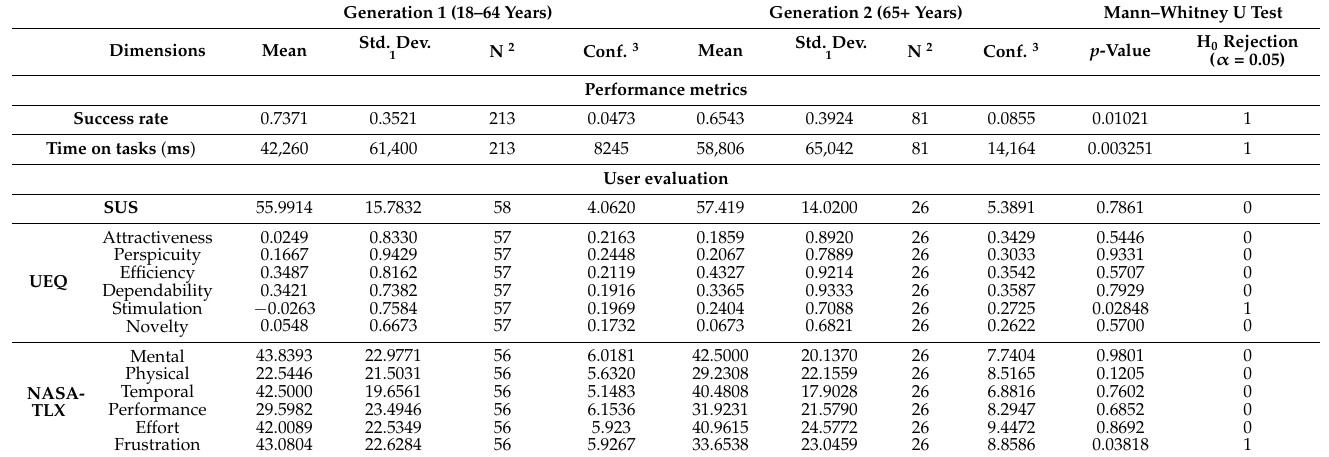
Table 4. Performance metrics and user evaluation of interfaces between generations.